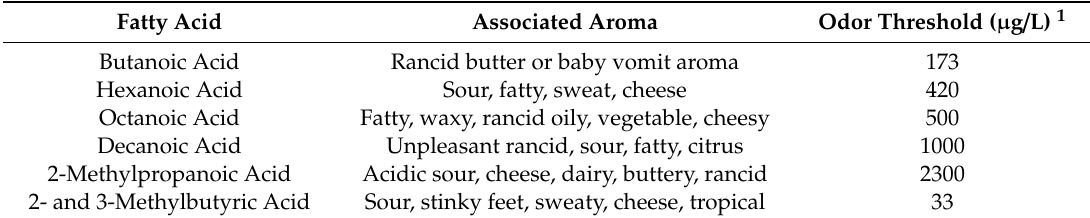
Table 2. Main medium-chain fatty acids (MCFAs (C 6 to C 12 )), produced by yeasts during alcoholic